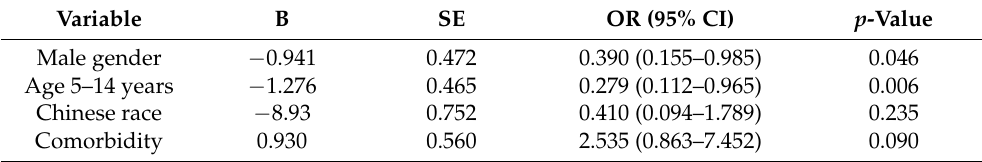
Table 4. Multivariate analysis of predictors of unsuccessful treatment